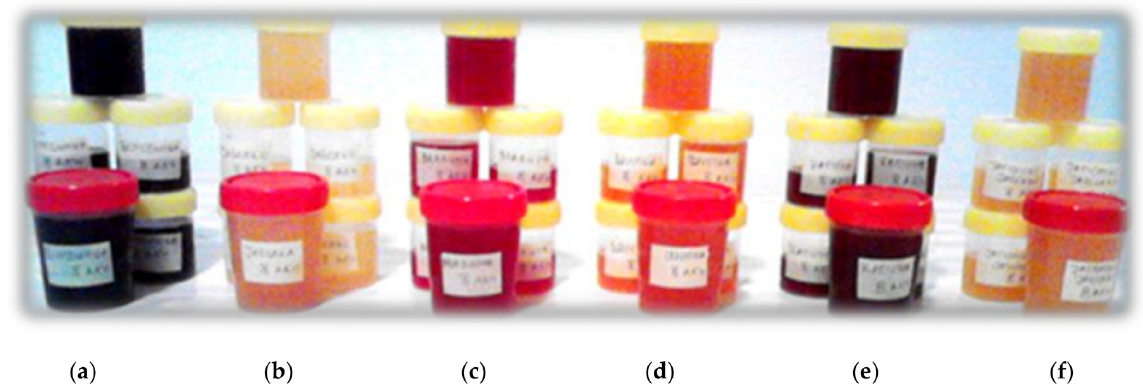
Figure 1. Homemade vinegar (HMV) aliquots at one point of fermentation in closed 50 mL sterile bottles (six samples from double batch per type of fruit): ( a ) blueberry ( Vaccinium myrtillus ); ( b ) apple ( Malus domestica ); ( c ) raspberry ( Rubus idaeus ); ( d ) rose hip ( Rosa canina ); ( e ) blackberry ( Rubus fruticosus ); ( f ) persimmon ( Diospyros kaki